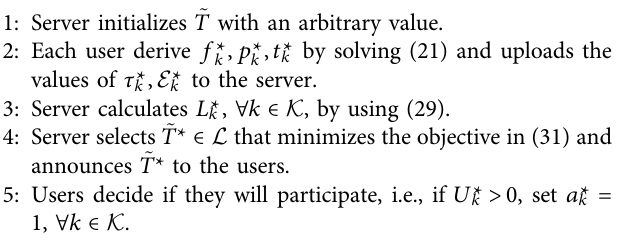
Algorithm 2. Stackelberg